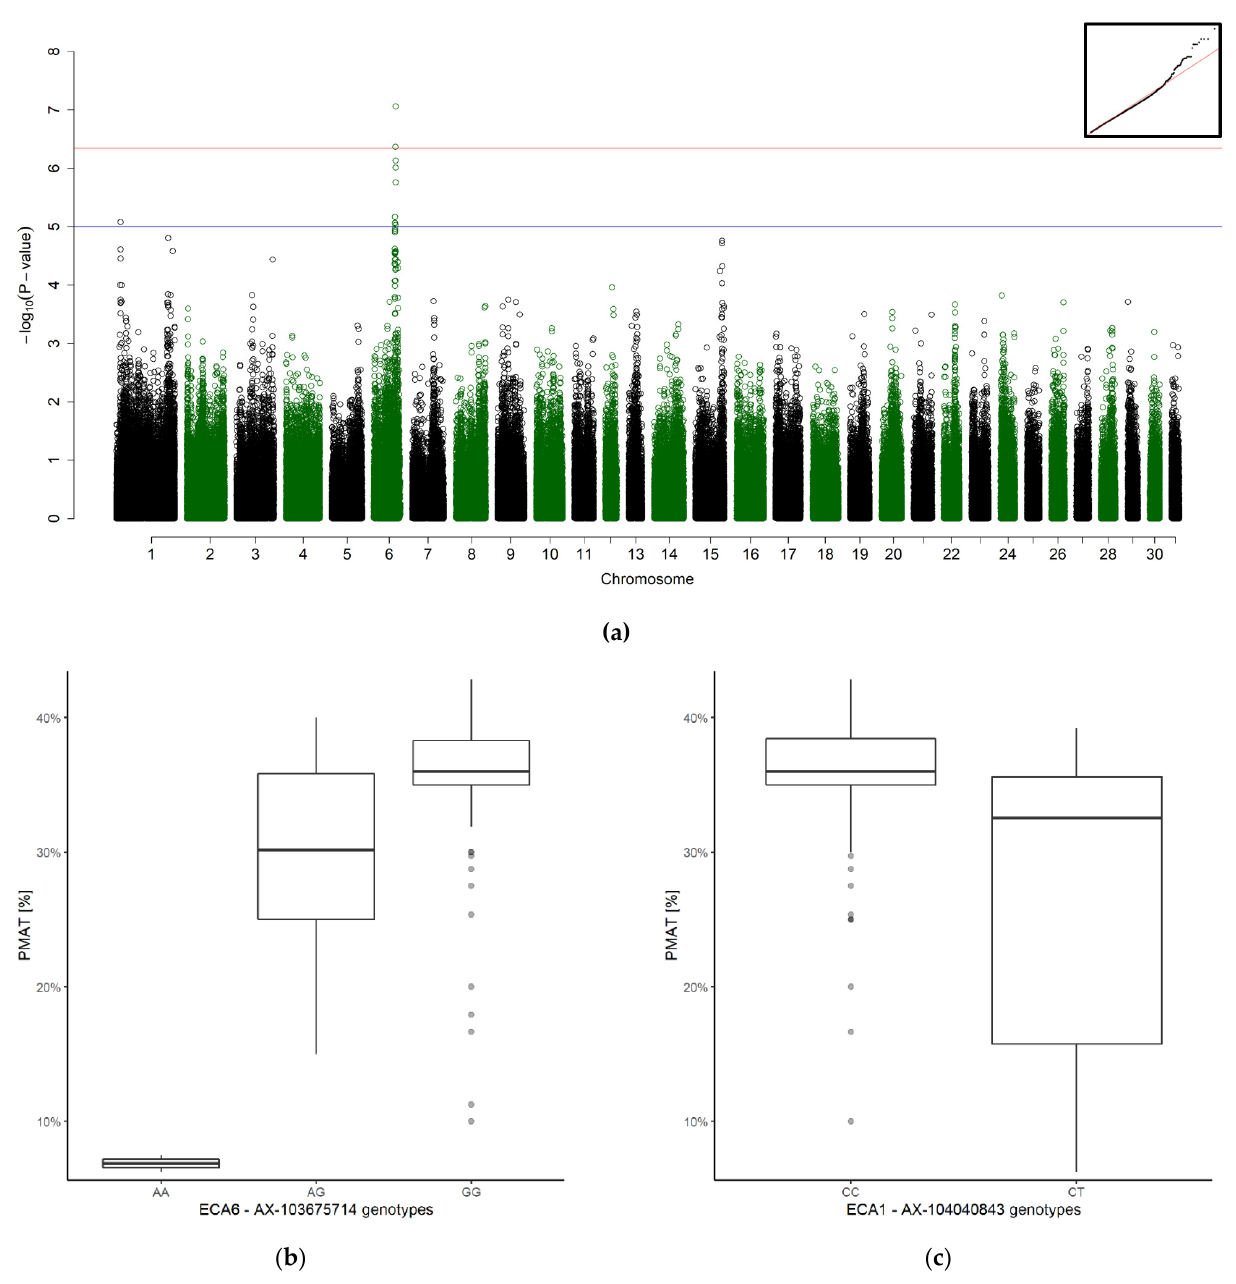
Figure 1. Genome-wide association for progressive motility after thaw (PMAT, n = 109). ( a ) Manhattan plot (blue line representing the suggestive significant threshold ( p < 10 − 5 ) and (red line) the Bonferroni-corrected significance threshold ( p ind < 4.56 × 10 − 7 ). The inset on the right-hand corner shows the quantile-quantile (Q-Q) plot with the observed p -value plotted against the expected one. ( b , c ) Boxplots representing the genotype effect of the best associated SNP on ECA6 ( b ) and ECA1 ( c ) on progressive motility after thaw.